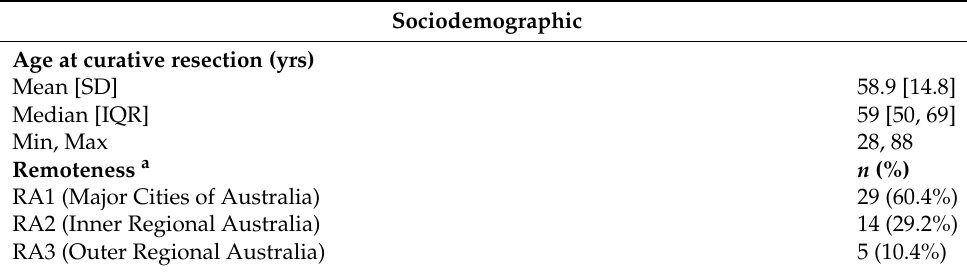
Table 1. Sociodemographic and Disease Characteristics of the Study Population ( n = 48).